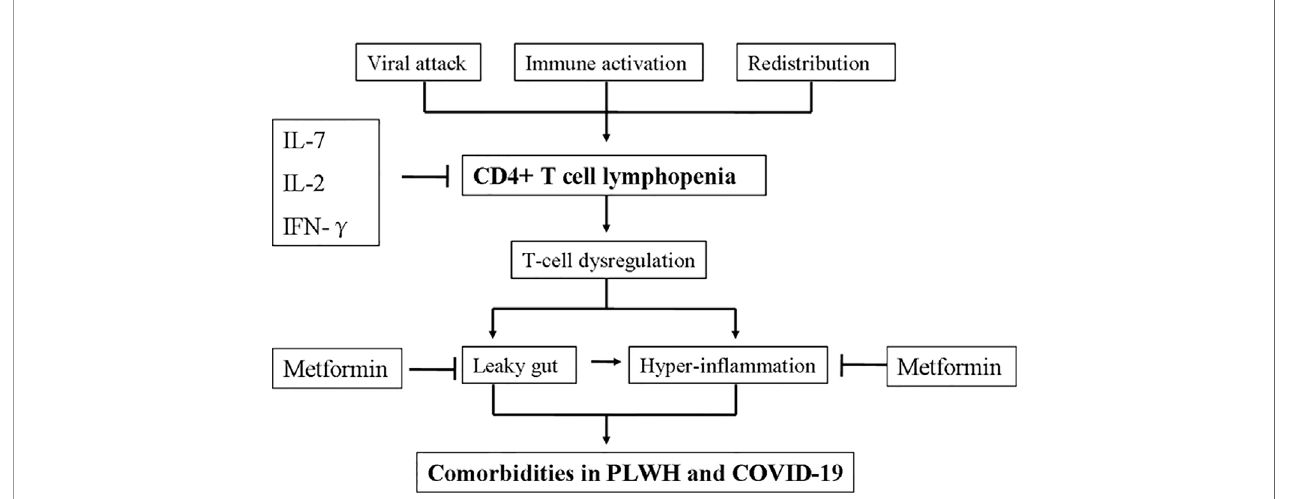
FIGURE 3 | Potential mechanism and consequence of CD4+ lymphopenia in people living with HIV (PLWH) and coronavirus disease-19